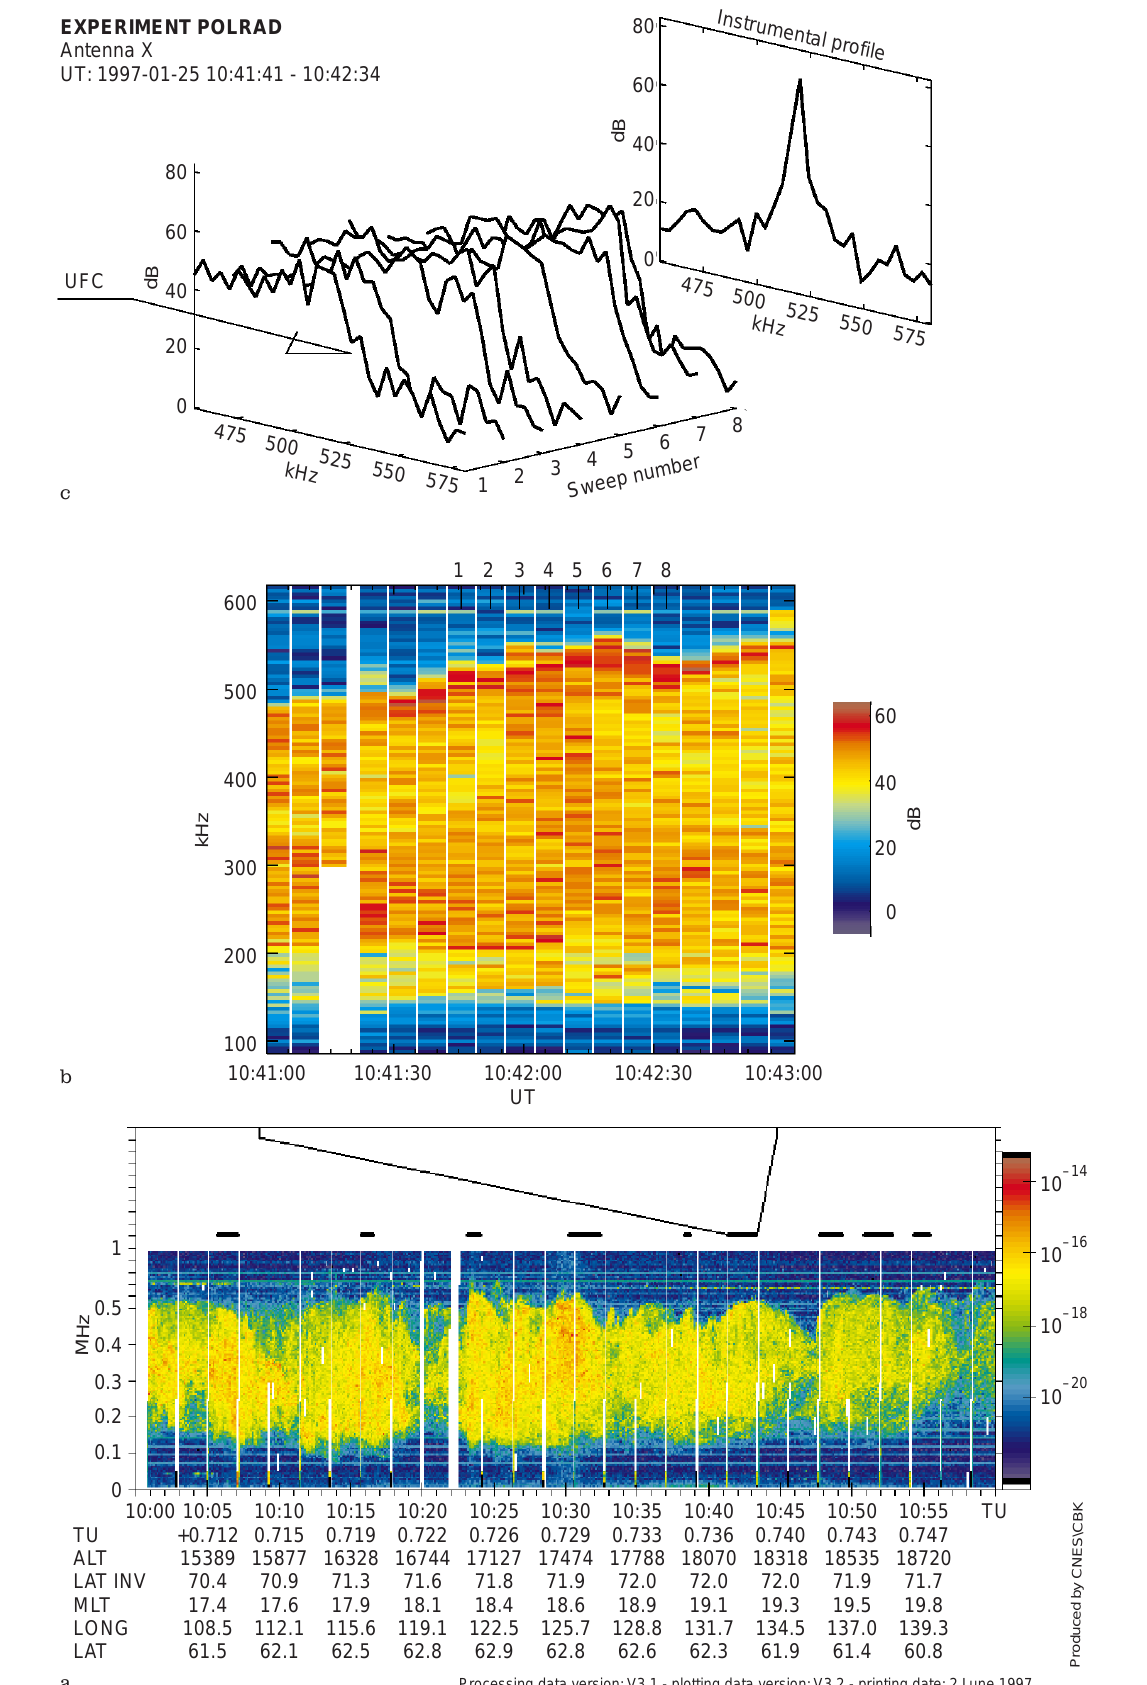
Processing data version:V3.1 - plotting data version:V3.2 - printing date:2 June